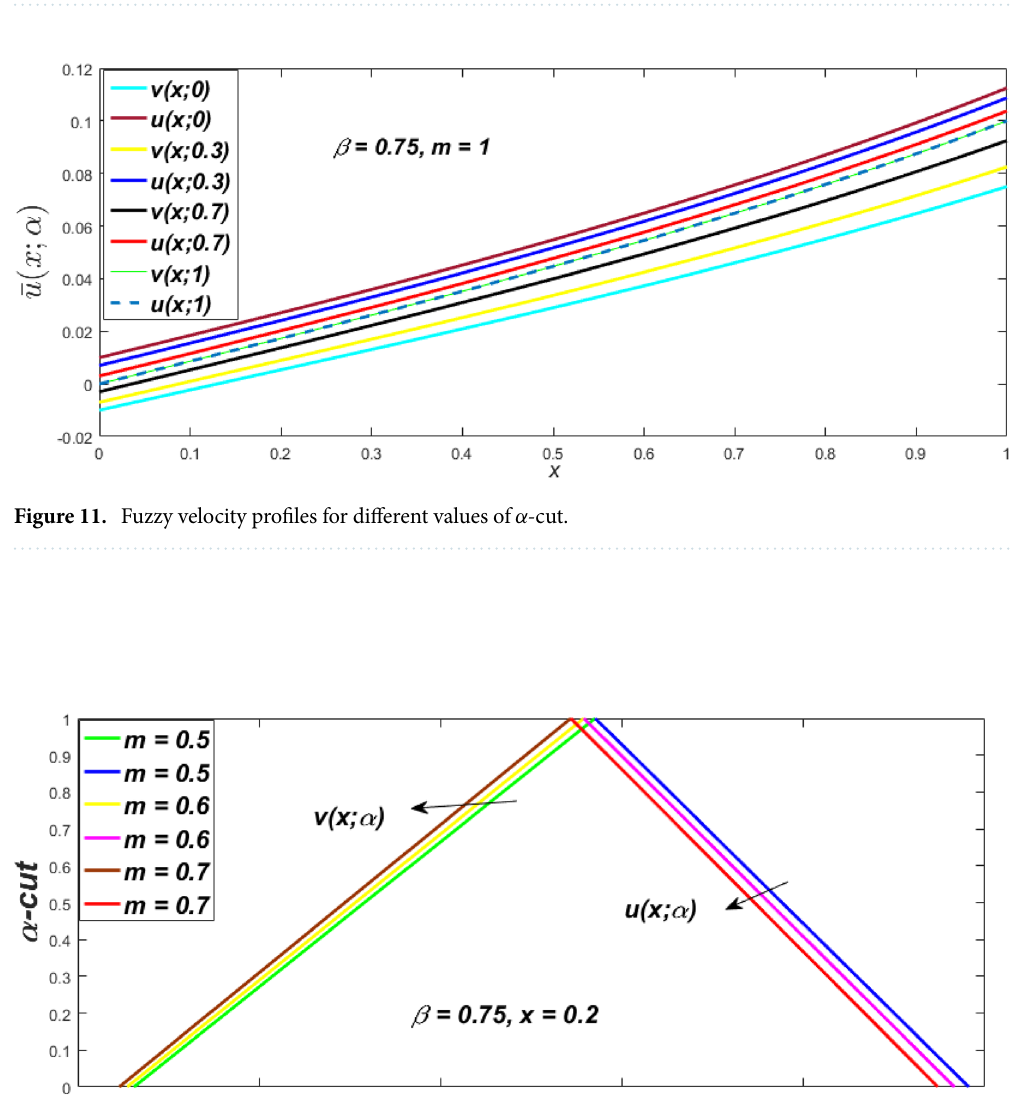
Figure 10. Fuzzy velocity profiles for the impact of β .